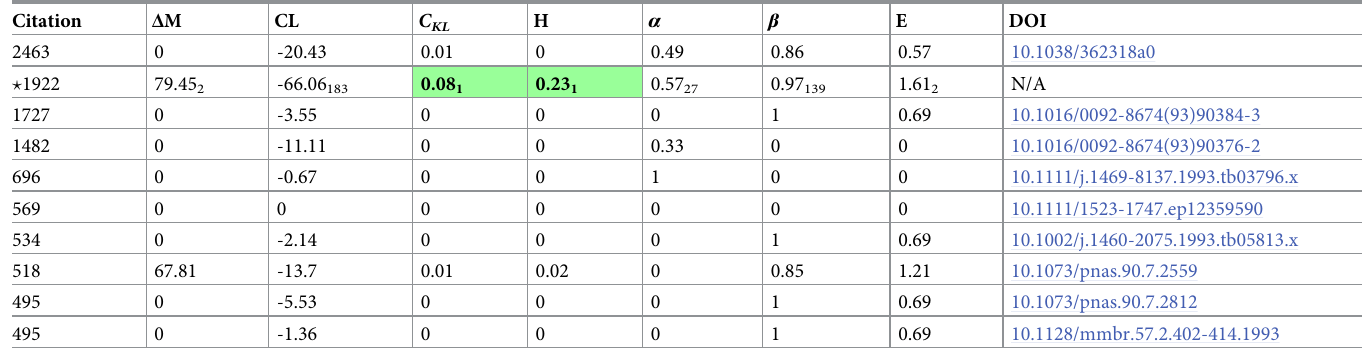
Table 9. Case 3 with pseudopaper. SVA metric scores of the top-10 most cited papers in the network containing Ps ( S 3,1 � S 3,2 )) (denoted by ? ) with scaling factor 25 ( k = 25; 1988-1993). A total of 208 citing papers made novel co-citation links. SVA score ranges: Δ M:0.0–80.09 | CL:0.0–66.06 | C KL :0.0–0.08 | H:0.0–0.23 | α :0.0–1.0 | β :0.0–1.0 | E: 0.0–1.68. Citation